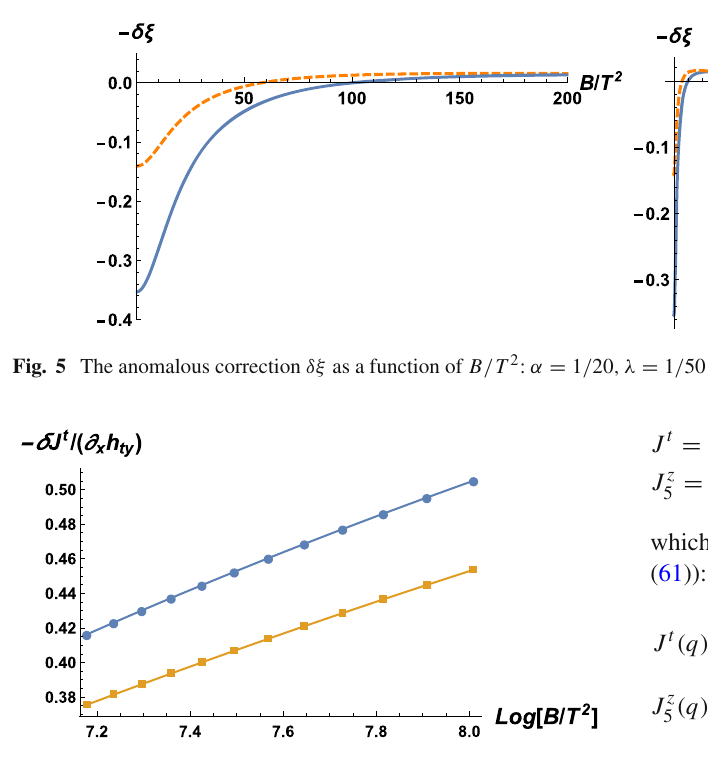
Fig. 6 Theanomalouscorrection (cid:13) δ J t T ty (cid:14) /( iq ) inunitof r 2 tion of log ( B / T 2 ) : α = 1 / 20 ,λ = 1 / 50 for the squared points and α = 1 / 20 ,λ = 1 / 20 for the circled